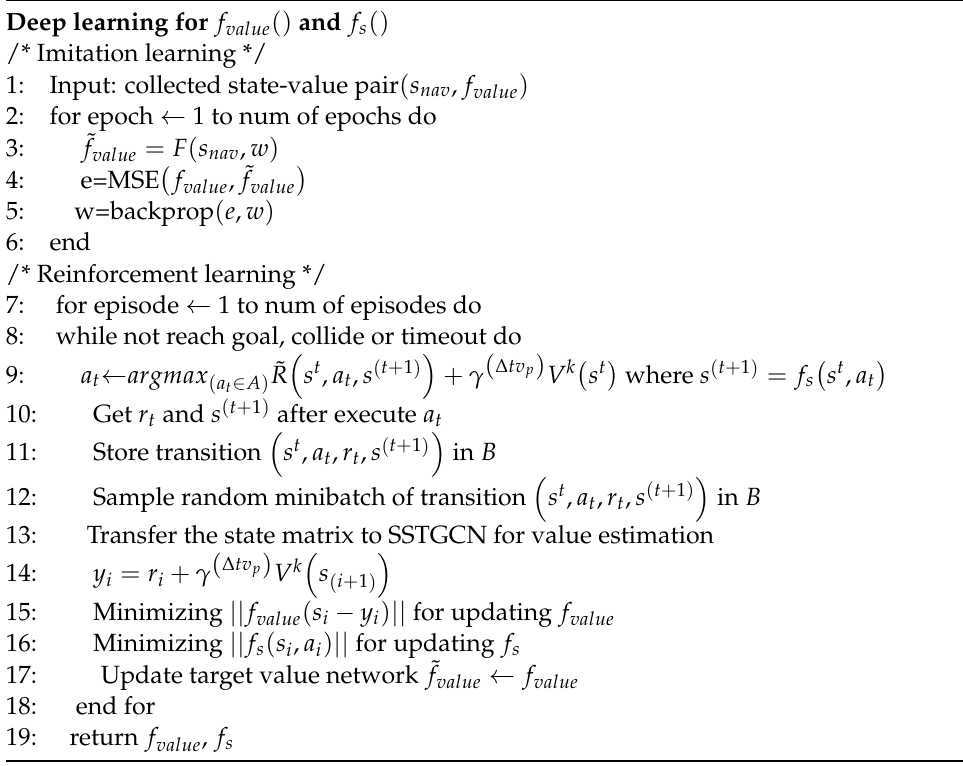
Algorithm 1. This table shows the training process of the algorithm, which includes Imitation learning and Reinforcement